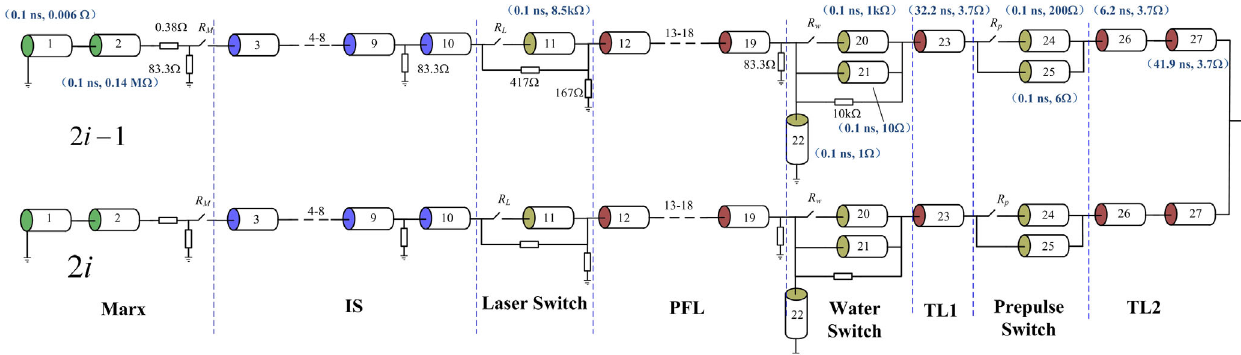
FIG. 11. Detail of the circuit before the water convolute. Module 2 i − 1 and 2 i are in the same angular position, sharing the same oil tank and water convolute. Before the water convolute, they have identical circuit parameters, which are shown in the figure. For all lumped capacitance and inductance, the transit length is 0.1 ns, and the impedance is determined by Eqs. (A1) and (A2). The resistance for each component is fitted from